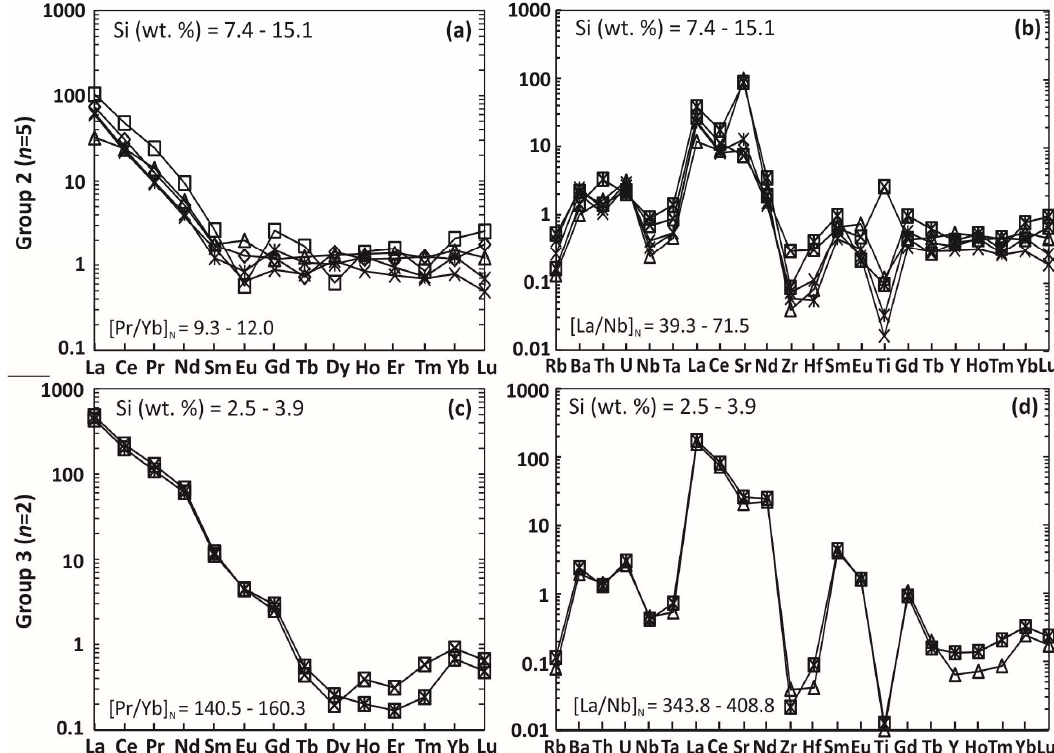
Figure 14. Chondrite-normalised REE ( a , c ) and primitive mantle-normalised [88] trace-element plots ( b , d ) for group 2 ( a , b ) and group 3 ( c , d ) carbonate grains. Note: due to the small size of carbonate grains, laser ablation (LA)-ICP-MS analyses include variable proportions of silicate material, as indicated.